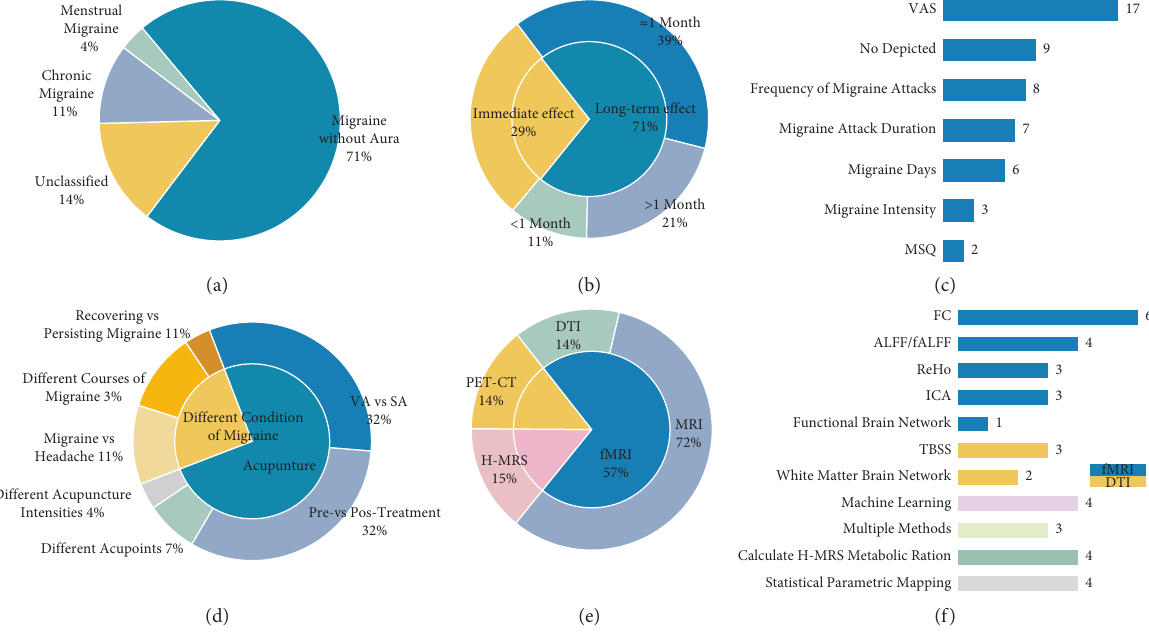
Figure 1: The study design of included studies. (a) The proportion of different types of migraine. (b) The proportion of treatment session. (c) The proportion of clinical variables of migraine. (d) The proportion of control types. (e) The proportion of scanning techniques. (f) The proportion of analysis methods of neuroimaging data. VA, verum acupuncture; SA, sham acupuncture; VAS, visual analogue scale; MSQ, Migraine-Specific Quality of Life Questionnaire; H-MRS, proton magnetic resonance spectroscopy; PET-CT, positron emission to- mography-computed tomography; MRI, magnetic resonance imaging; fMRI, functional magnetic resonance imaging; DTI, diffusion tensor imaging; ALFF, amplitude of low-frequency fluctuations; FC, functional connectivity; ReHo, regional homogeneity; ICA, independent components analysis; TBSS. tract-based spatial